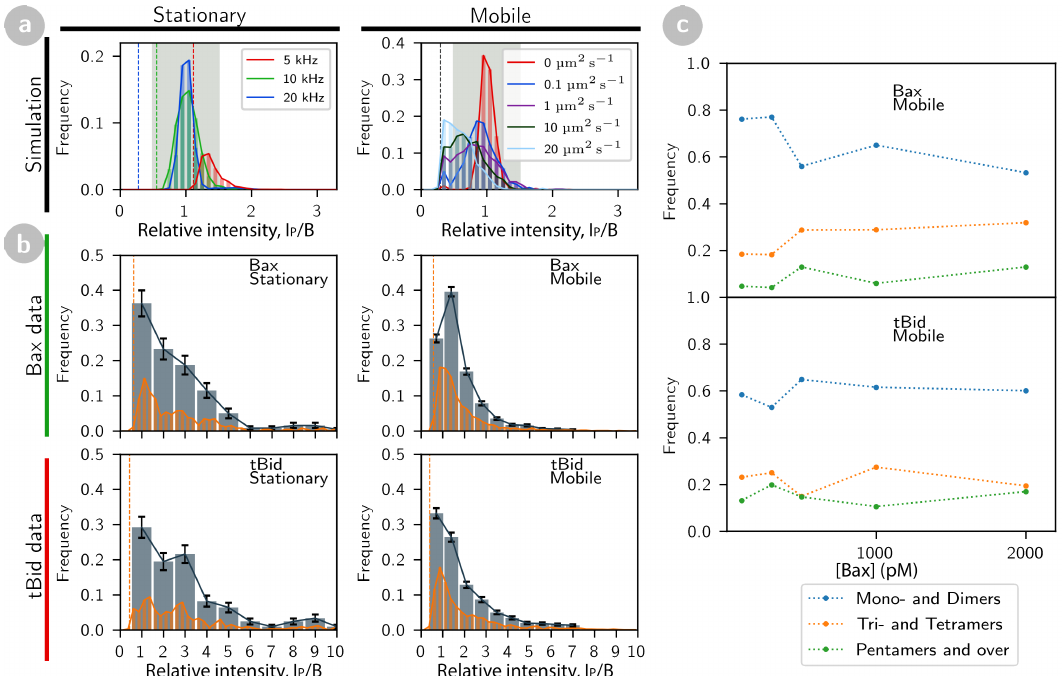
Figure 4. Intensity distribution and stoichiometry of detected events. ( a ) Intensity distributions for events detected in simulated confocal images for either stationary particles with different brightness (left panel) or particles with brightness B = 20 kHz and different diffusion coefficients. ( b ) Intensity distributions for events detected in confocal images of SLB incubated with tBid-Alexa647 and Bax-HyLite488, classified for each protein into stationary and mobile particles (regardless of Bax concentration). All intensities have been normalized by the known particle brightness of the monomer. The experimental distributions are binned in two different ways, with a small bin width of B /4 for visualization (orange bars) and with a larger bin width of B or 0.7 B for stationary and mobile particles, respectively, representing the expected apparent brightness of a monomer for these two types of particles (blue bars). The coarse binning thus provides an estimate of the relative abundance of different protein stoichiometry. In ( a , b ), the dashed vertical bars indicate the threshold intensity used for particle detection. ( c ) Oligomer frequency versus Bax-HyLite488 concentration (for a constant 0.2nM tBid-Alexa647